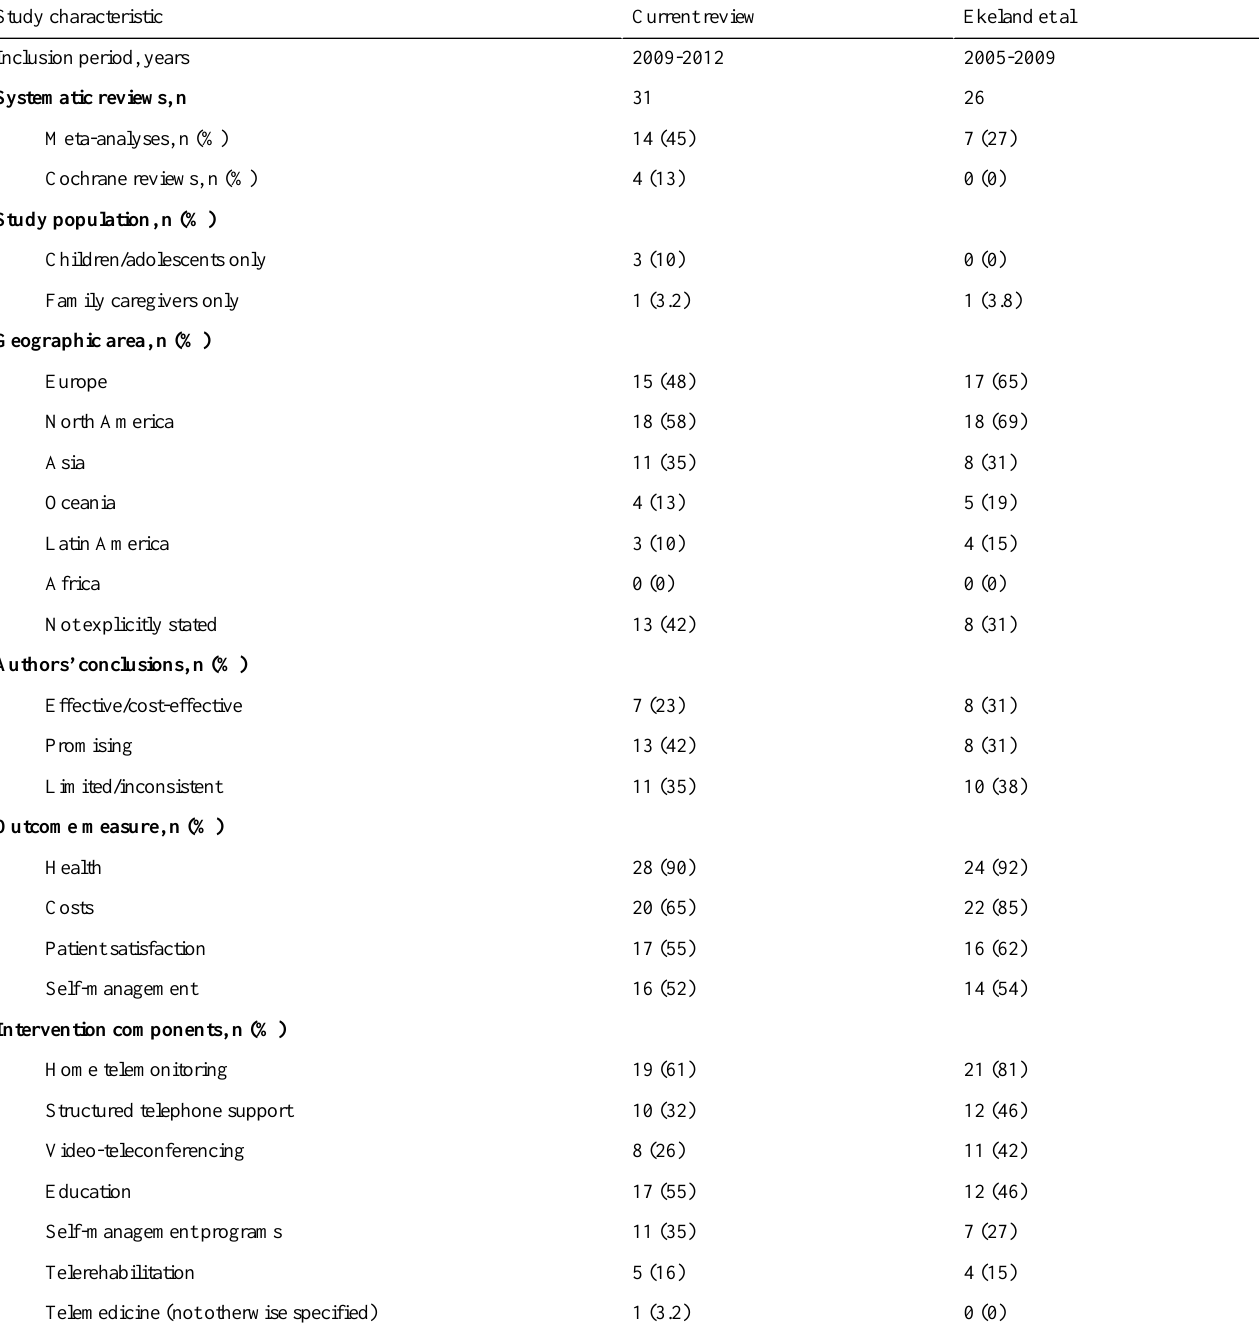
Table 7. Trend analysis of differences in study characteristics of the current review compared with the review by Ekeland et al [9] published in 2010.